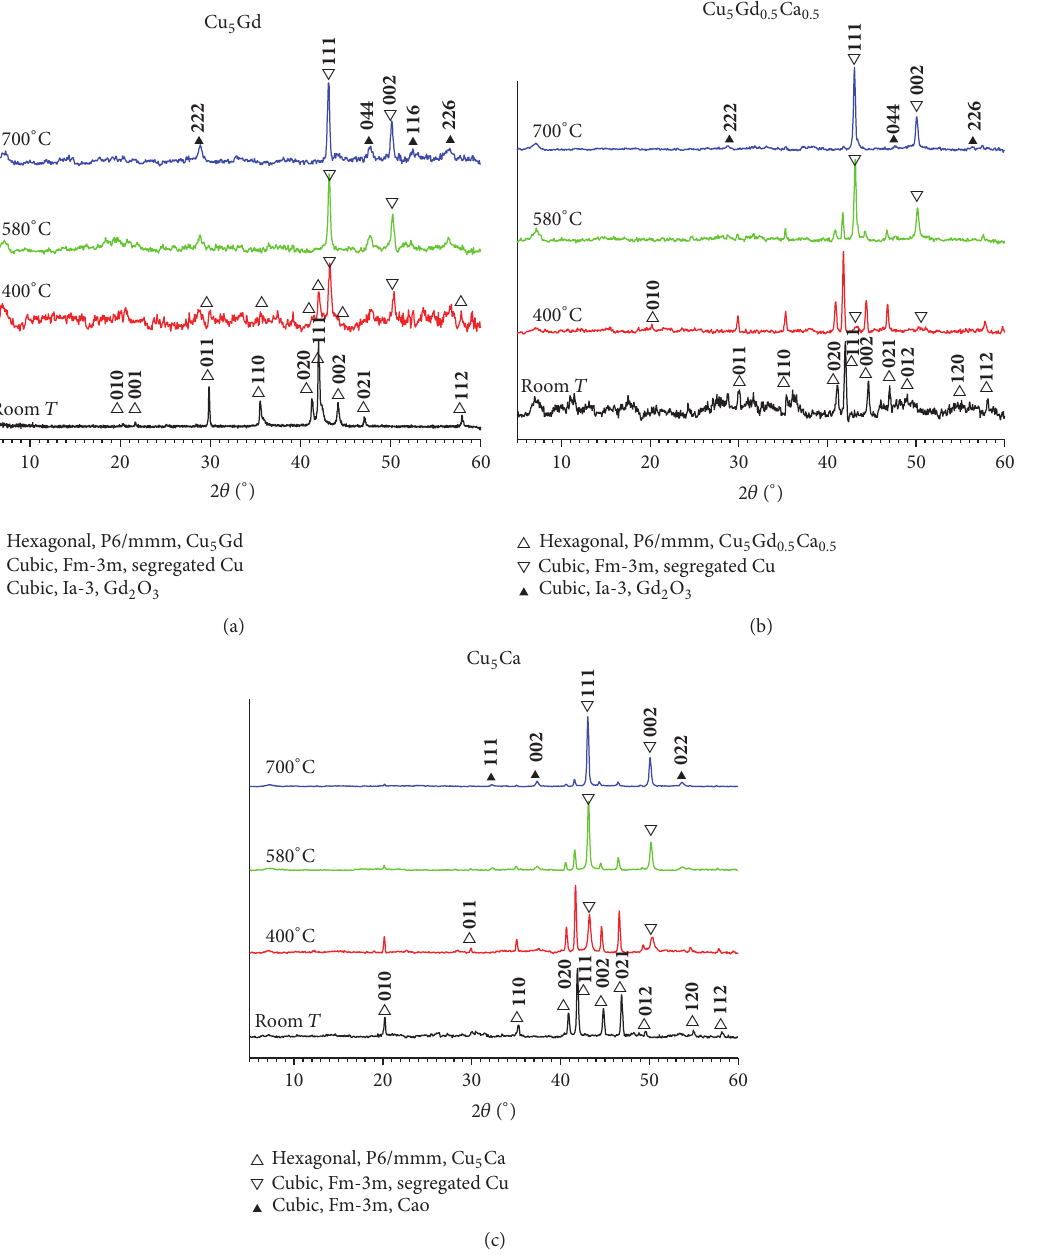
Figure 7: (a–c) High temperature XRD patterns of Cu 5 Gd 1−𝑥 Ca 𝑥 melt-spun ribbons recorded at room temperature, 400, 580, and 700 ∘ C; (a) 𝑥 = 0 , (b) 𝑥 = 0.5 , and (c) 𝑥 = 1 .